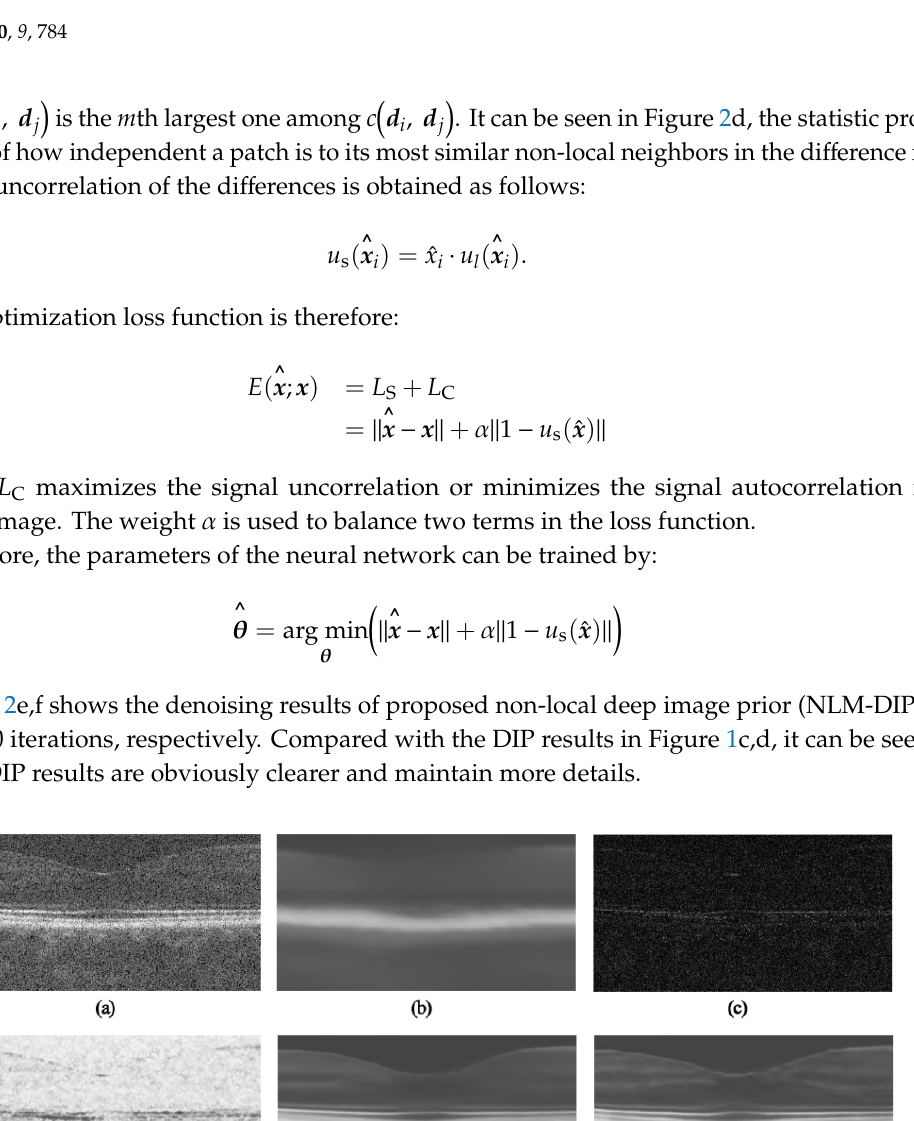
Figure 2. NLM ‐ DIP denoising OCT image: ( a ) input noisy image x , ( b ) constructed image ˆ x after Figure 2. NLM-DIP denoising OCT image: ( a ) input noisy image x , ( b ) constructed image 200 iterations, ( c ) absolute value of di ff erence image d between ( a ) and ( b ), ( d ) the uncorrelation 200 iterations, ( c ) absolute value of difference image d between ( a ) and ( b ), ( d ) the uncorrelation l u u l of di ff erence image, ( e ) constructed image with NLM-DIP speckle reduction after 450 iterations, of difference image, ( e ) constructed image with NLM ‐ DIP speckle reduction after 450 iterations, ( f ) ( f ) constructed image with NLM-DIP speckle reduction after 900 constructed image with NLM ‐ DIP speckle reduction after 900 iterations.